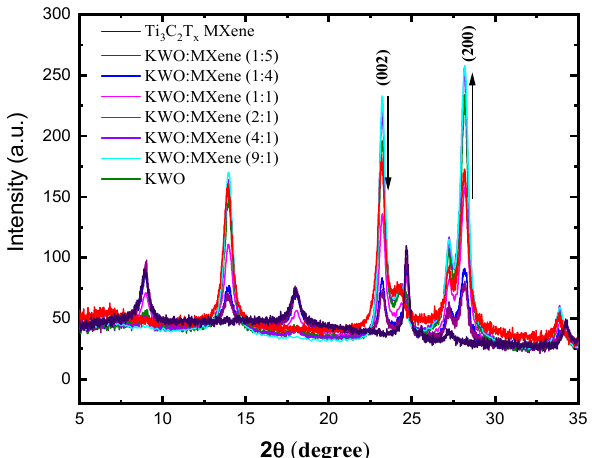
Figure 2. SEM images of ( a ) KWO nanorods, ( b ) Ti 3 C 2 T x , ( c ) KWO / Ti 3 C 2 T x (2:1), ( d ) KWO / Ti 3 C 2 T x